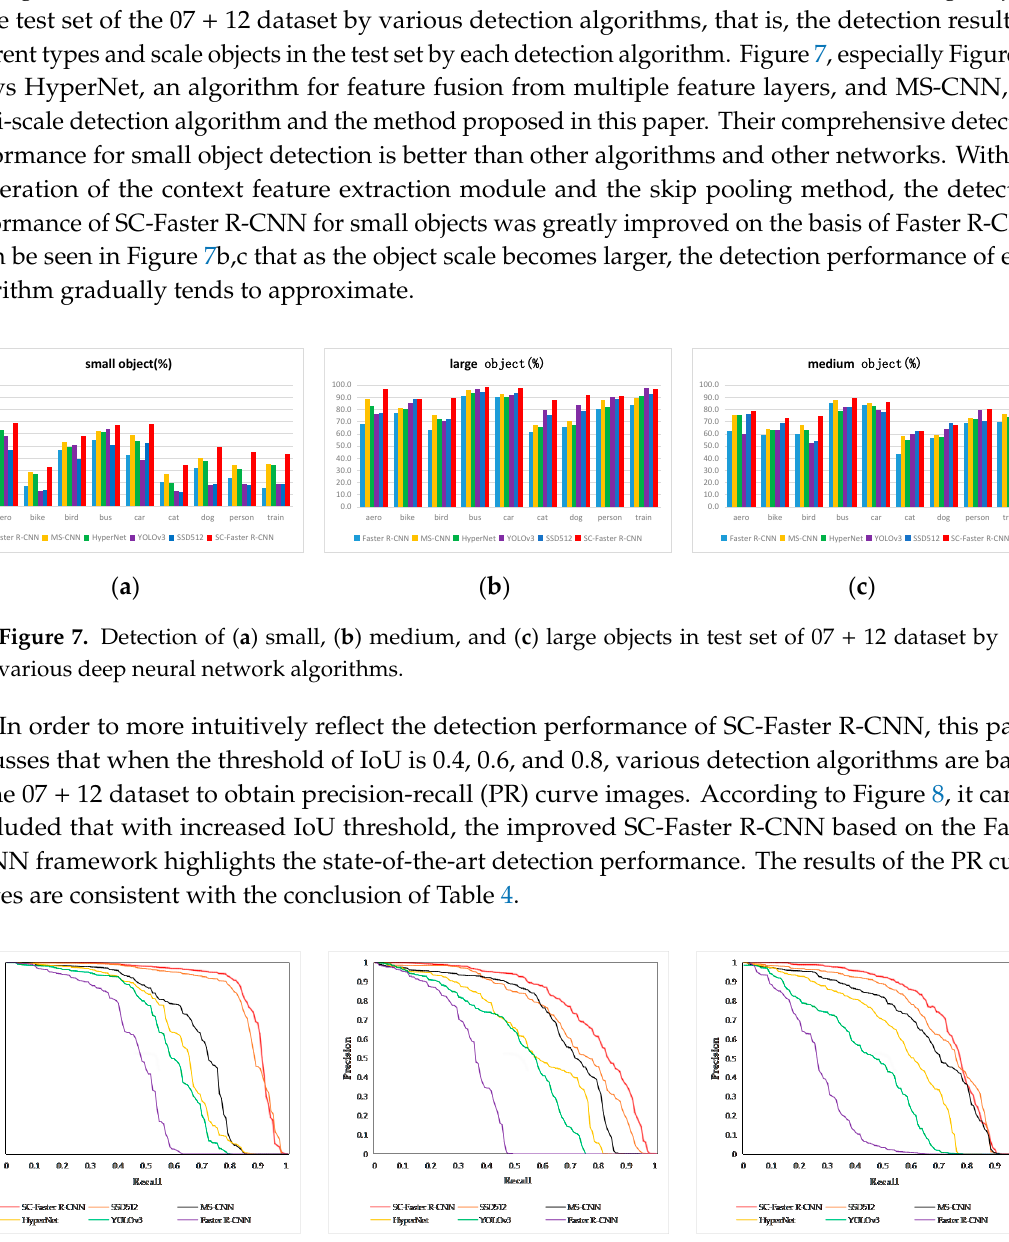
Figure 8. PR curve images of various deep neural network algorithms. The object detection situation for different networks in the 07 + 12 dataset can be seen more intuitively when the threshold of intersection over union (IoU) is different: ( a ) when IoU = 0.4, the overall detection performance of each network is not much different, but SC-Faster R-CNN is better than other networks; ( b ) when IoU = 0.6, the detection performance of most networks drops sharply, but that of SC-Faster R-CNN is stable; ( c ) when IoU = 0.8, the overall detection performance of each network decreases, but SC-Faster R-CNN still has splendid detection performance compared to other networks.